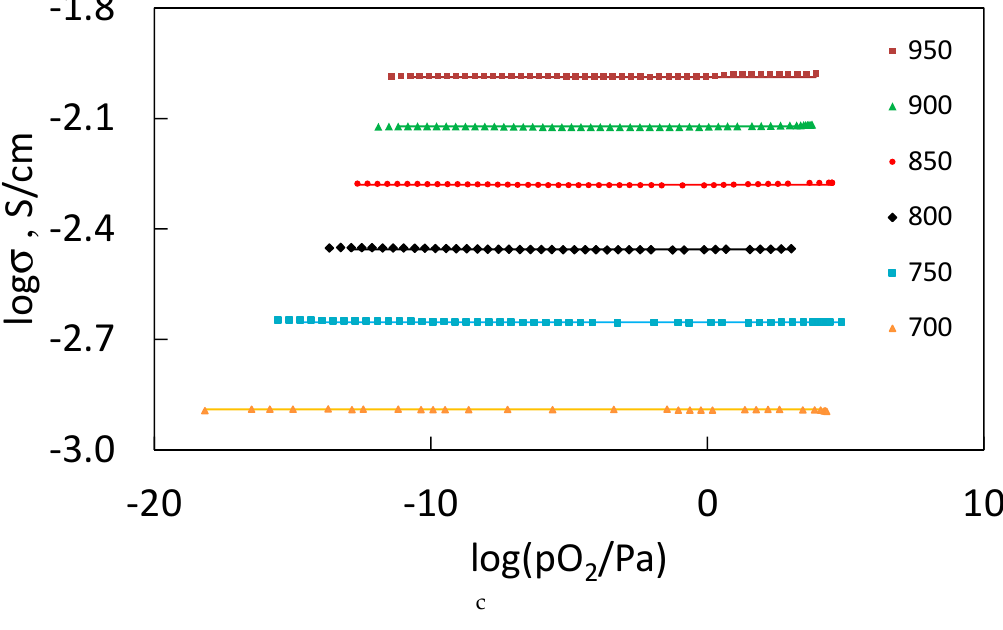
Figure 11. Total electrical conductivity of ( a ) Sm 2 − x Ca x Zr 2 O 7 − x / 2 (x = 0.05), ( b ) Sm 2 − x Ca x Zr 2 O 7 − x / 2 (x = 0.1), ( c ) Gd 2 − x Ca x Zr 2 O 7 − x / 2 (x = 0.1) as a function of the oxygen partial pressure, for temperatures between 700 and 950 °C.